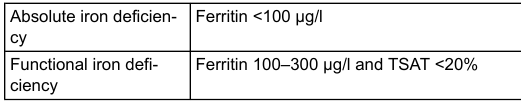
Table 1: Diagnosis of absolute and functional iron deficiency in chronic heart